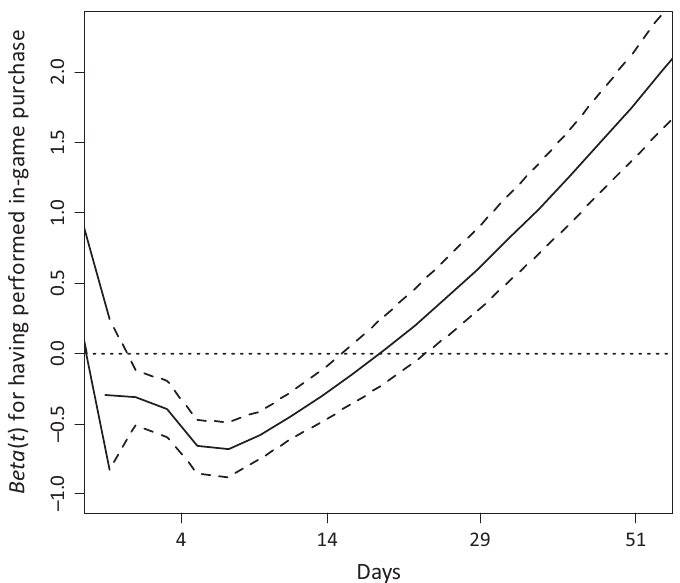
Figure 2. Estimated Beta ( t ) ( df = 8) for having performed at least one in-game purchase up until time t over time (log[days]). of 0.2 (see Figure A3 in the Supplementary File).